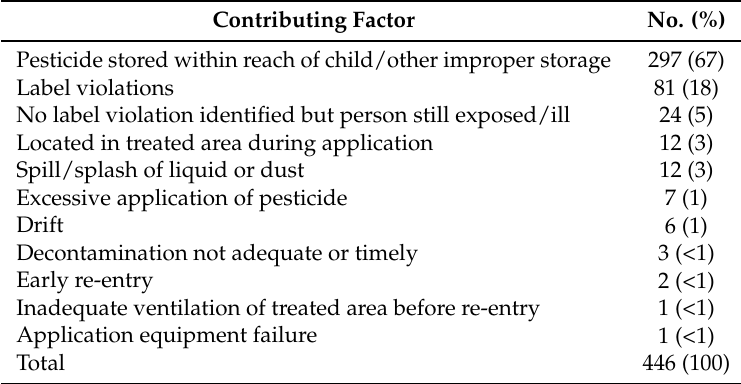
Table 7. Distribution of events in childhood reported by contributing factor of accidental causes.